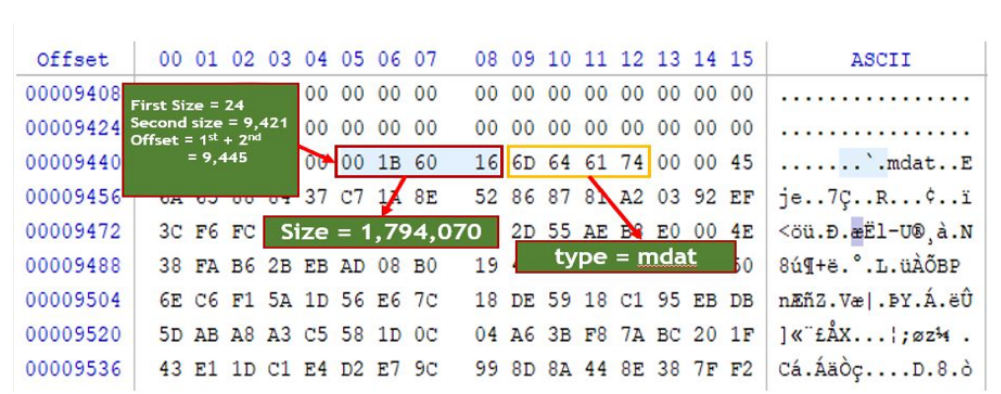
Figure 7. Third chunk of a sample MP4